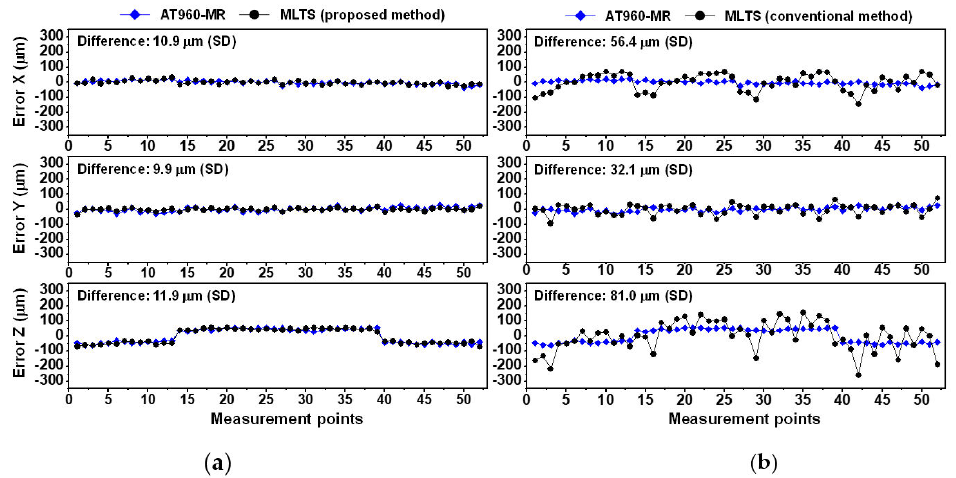
Figure 13. Comparison of CMM errors measured by AT960-MR and MLTS in Experiment 3: ( a ) Proposed self-calibration method; ( b ) Conventional self-calibration